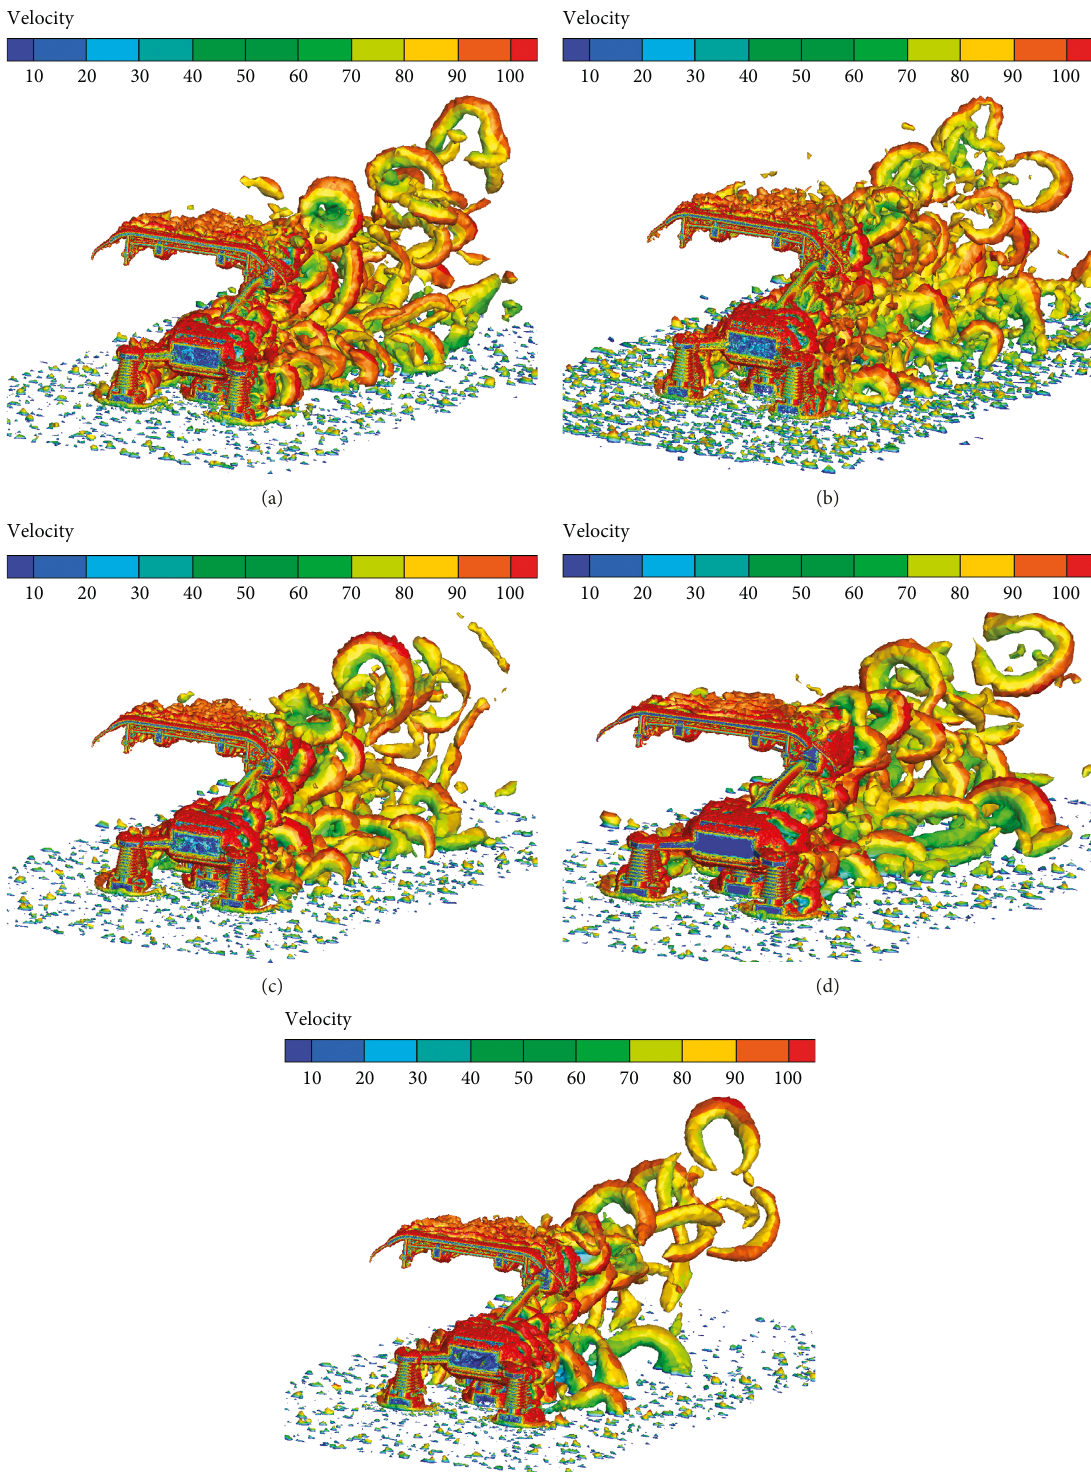
Figure 12: Instantaneous vortex structure of (a) LES, (b) SAS, (c) IDDES sst-k ω , (d) DDES sst-k ω , and (e) DDES R-k ε